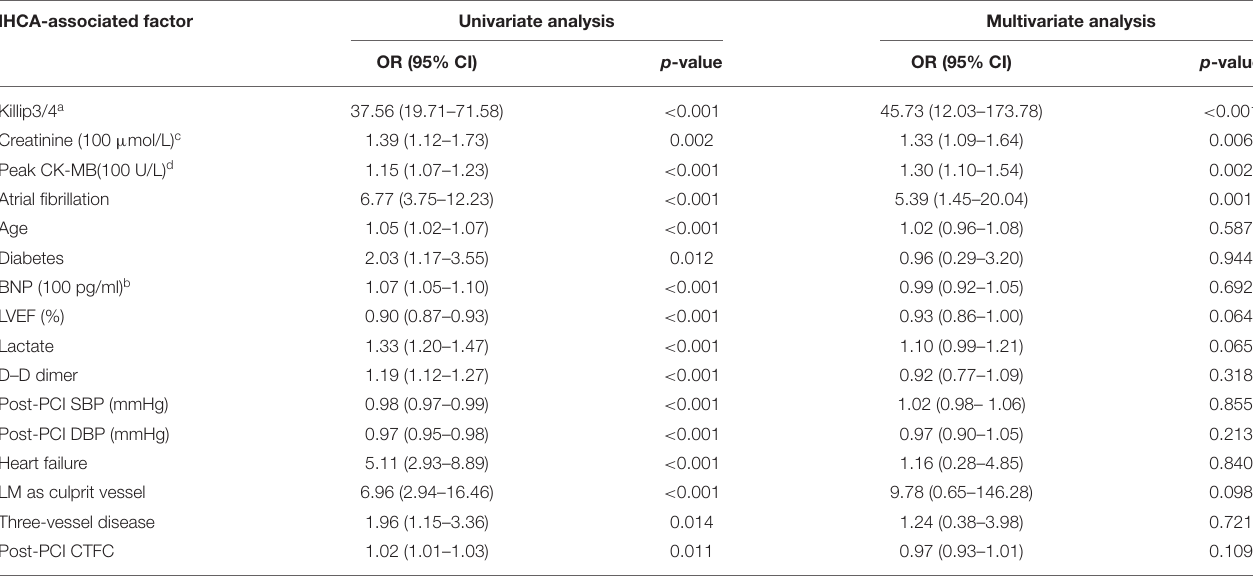
TABLE 4 | Independent predictors of POCA